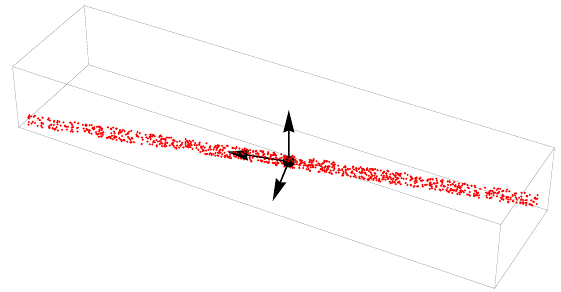
Figure 1: Basis consiting of eigenvectors of the variance covari- ance matrix of the points in a